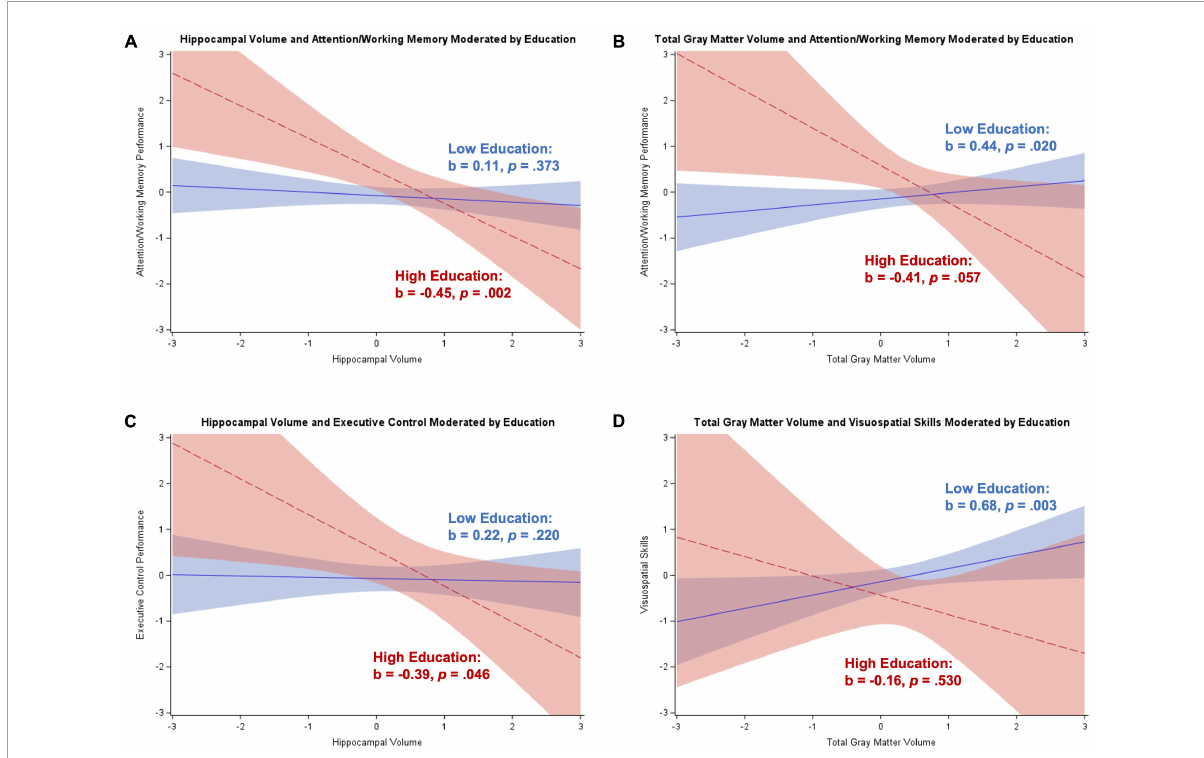
FIGURE8 Plots of significant moderations by education of the associations between brain volume and cognition for women with dementia. High education corresponds to 1 SD above the mean and low education corresponds to 1 SD below the mean. The red dotted line represents high education, and the blue solid line represents low education. Shaded areas represent 95% confidence intervals. Cognition and brain volume were standardized. (A) Significant negative association between hippocampal volume and attention/working memory for participants with high education; non-significant positive association for low education. (B) Non-significant negative association between total gray matter volume and attention/working memory for participants with high education; significant positive association for low education. (C) Significant negative association between hippocampal volume and executive control for participants with high education; non-significant positive association for low education. (D) Non-significant negative association between total gray matter volume and visuospatial skills for participants with